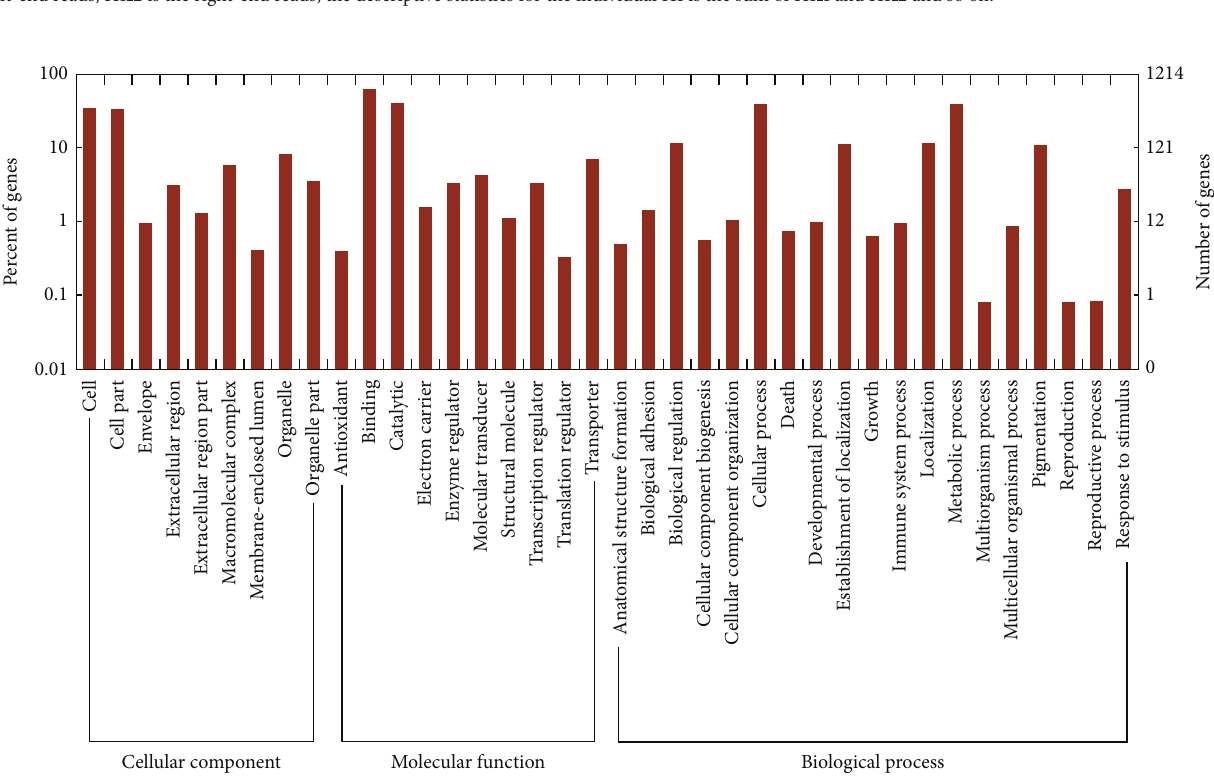
and fatty acid-binding protein 10-A, liver ( L-FABP ). At the same time, 782 transcripts showed higher expression levels in low carcass fat content fish, including many transcription factors with important effects on growth, differentiation, lipid metabolism, carbohydrate metabolism, and immunity, for example, growth hormone receptor isoform 1 ( GHR1 ), insulin-induced gene 1 ( INSIG1 ), and heat shock 70 kDa protein ( HSP70